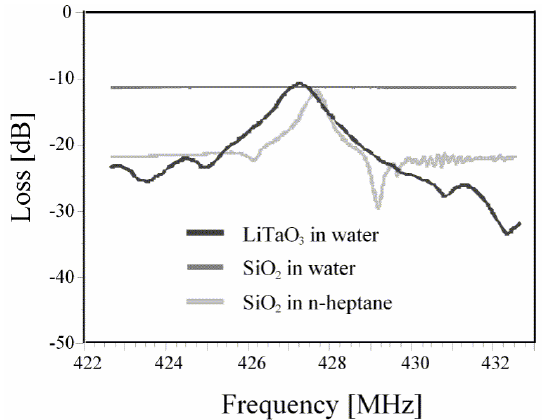
Figure 3. Damping spectra of LiTaO 3 and SiO 2 in water. Damping of SiO 2 in n -heptane is also shown. It is seen here that SiO 2 has no resonance spectrum in water due to its high dielectric constant (≈80). However, SiO 2 shows some damping spectra in n -heptane that has dielectric constant of about 1.9. LiTaO 3 exhibits suitable resonance in water, demonstrating its ability to work in aqueous phases. Adapted with permission from [45], copyright (2010) Elsevier.